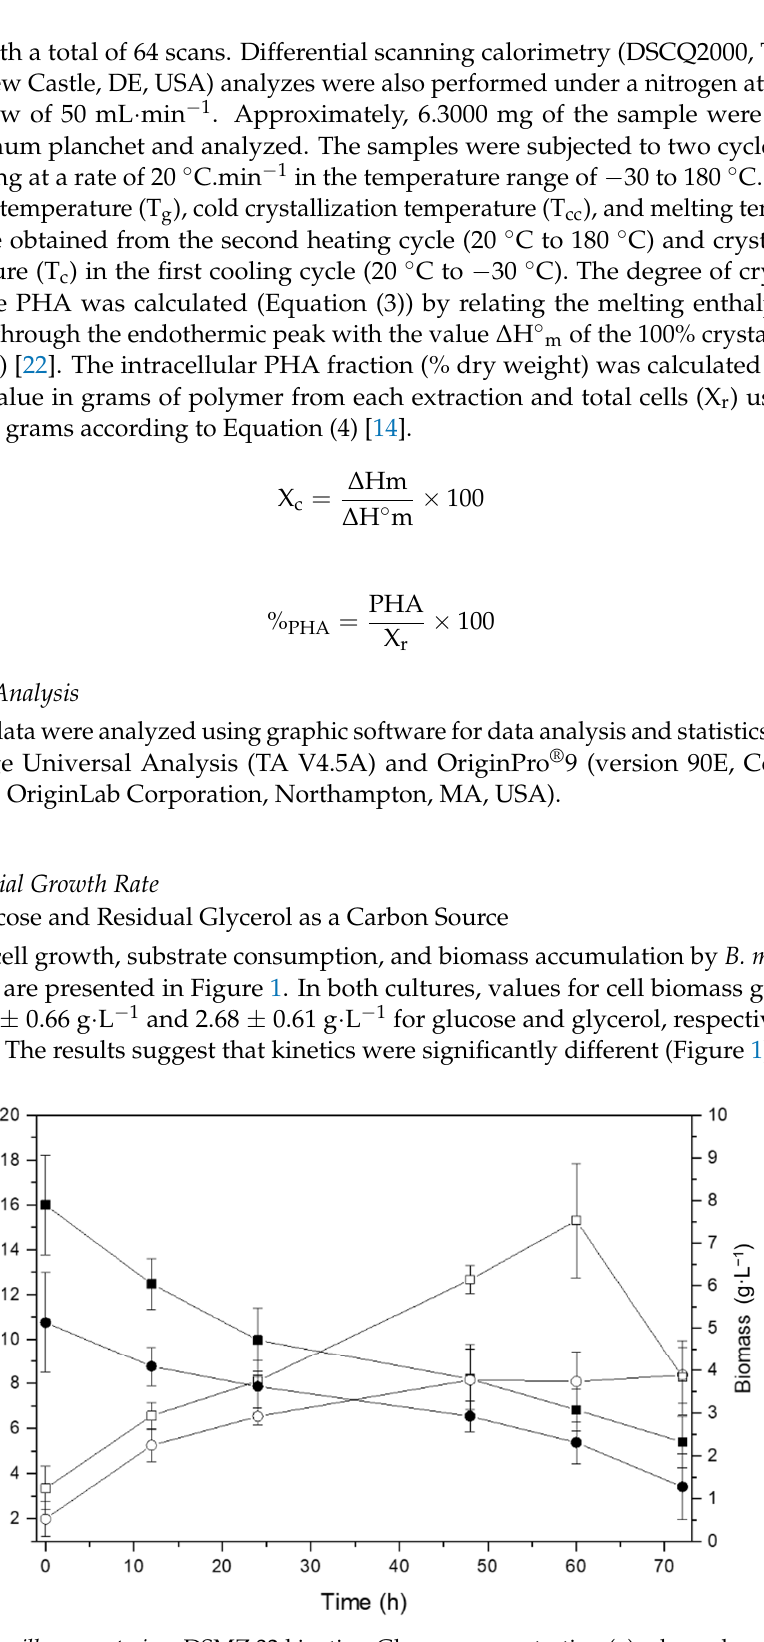
) and glycerol ( (cid:3) ) as (cid:35)